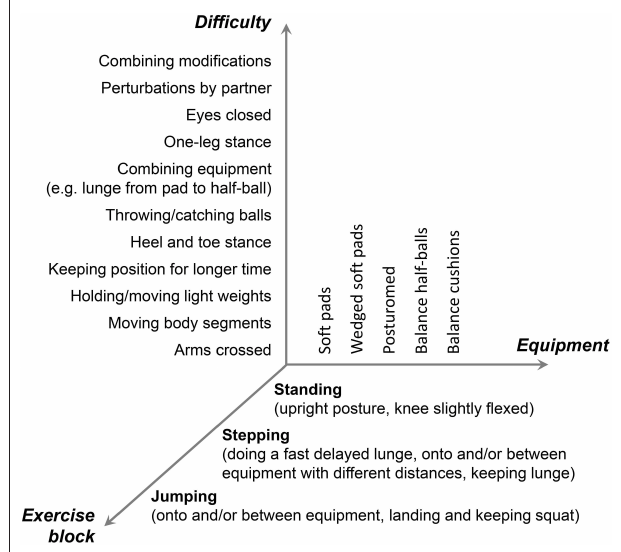
FIGURE 2 | Description of the concept of the training of the dynamic stability in the presence of perturbations. Participants trained each of the exercise blocks under unstable conditions introduced by the different kinds of used equipment. The balance intensity was kept high by modifying the exercises according to the individual performance level to challenge the application of the dynamic control mechanisms (horizontal and vertical axis).